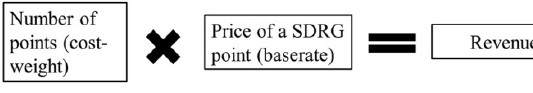
Figure 4. Remuneration computation.